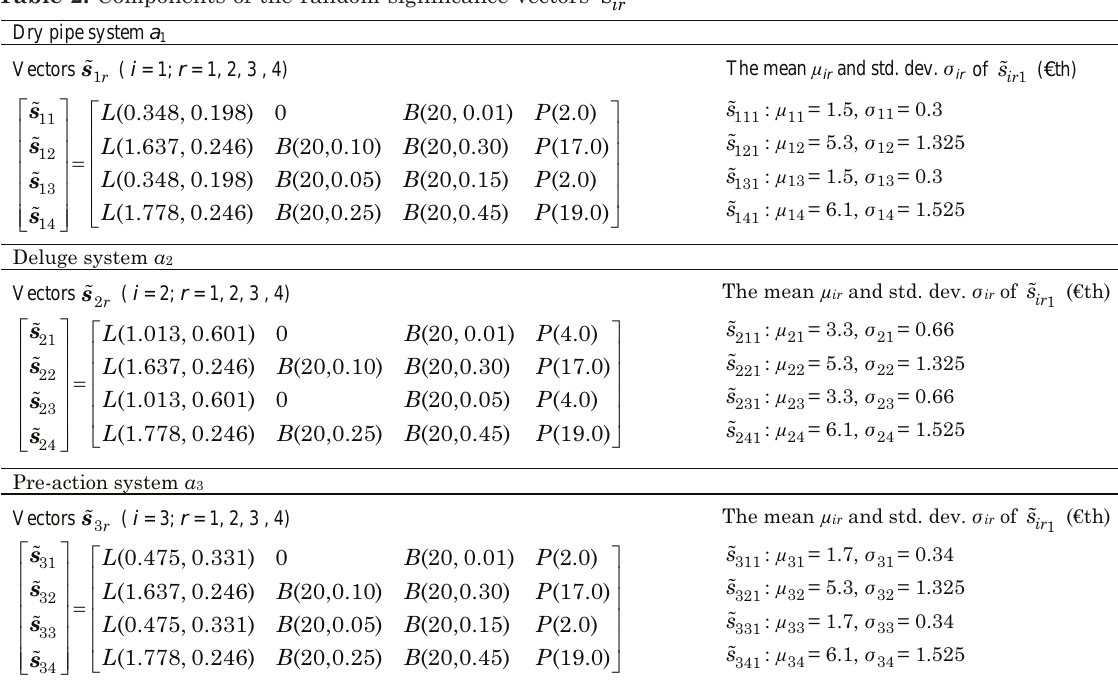
* the probability distributions and their parameters presented in the table are hypothetical; L (∙), B (∙) and P (∙) denotes lognormal, binomial and poisson distribution, respectively